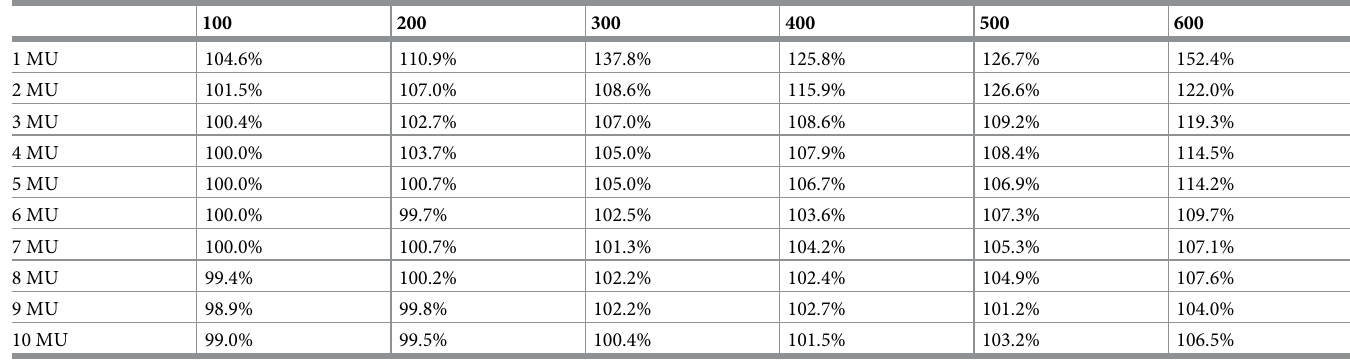
Table 1. Relative doses at the first segment in relation to the overshoot effect.